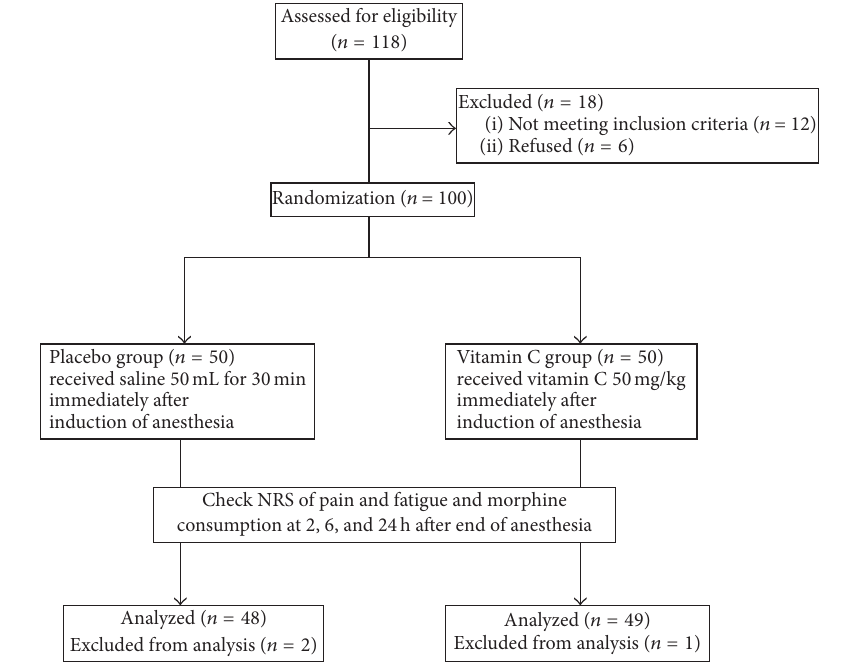
Figure 1: Flow chart describing recruitment, allocation, follow-up, and analysis. NRS, numeric rating